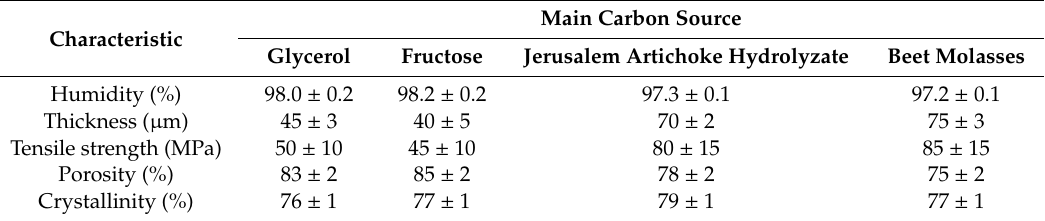
Figure 1. The appearance of a bacterial cellulose (BC) mat biosynthesized by immobilized K. xylinum cells in fructose-containing medium ( a ) before and ( b ) after cutting into pieces, which were further used to immobilize the enzyme. ( c ) The general view of poly(vinyl alcohol) cryogel (PVA-CG)/BC composites. SEM images of ( d ) BC, ( e ) PVA-CG, and ( f ) PVA-CG/BC/hexahistidine-tagged organophosphorus hydrolase (His 6 -OPH) composites. Individual nanofibers of BC, marked by red triangles, are seen within the initial material and its composite. Table 1. Characteristics of BC samples synthesized by K. xylinum B-12429 cells in the medium with different main carbon sources.